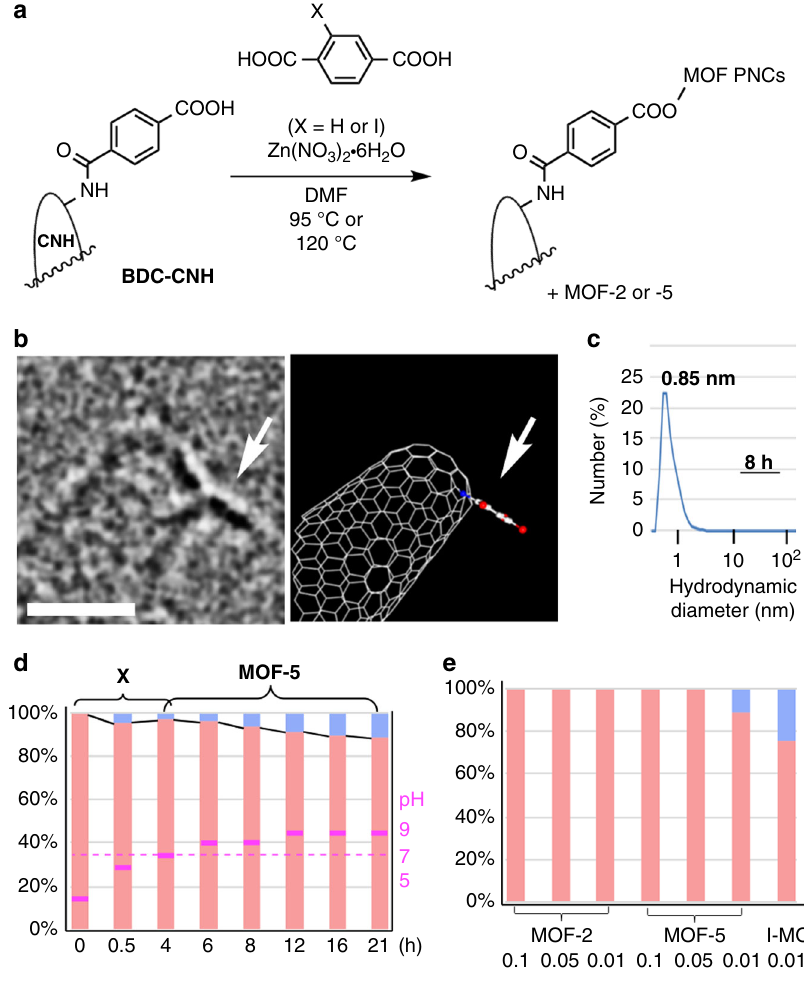
Fig. 2 BDC-CNH fi shhook for capturing PNCs of MOF-2 and MOF-5. a Procedure to capture PNCs of MOF-2 and MOF-5 on a ‘ fi shhook ’ of BDC-CNH. b TEM image (left) and molecular model (right) of a BDC moiety (indicated by an arrow) bound to the tip of the CNH. The scale bar is 1 nm. See Supplementary Fig. 7 for details. c DLS analysis (particle number average) of the fi ltrate of a reaction mixture of MOF-5 after 8 h. d The ratio between LO (pink) and HO (blue) clusters in the formation of X and MOF-5 at 120 °C. The data in purple indicate the pH of reaction mixture after dilution with water. The total number of the PNCs examined in the eight experiments shown are the following from the left to the right: 47, 27, 132, 133, 67, 58, 69 and 36. See in Supplementary Table 2 for the original data. e The LO/HO ratio at various Zn 2 + concentrations, as captured on BDC-CNH from the reaction of a mixture of H 2 BDC (or H 2 IBDC), Zn(NO 3 ) 2 (cid:129) 6H 2 O (2 equiv), and BDC-CNH heated for 21 h at 95 °C (MOF-2 formation) and 120 °C (MOF-5 and I-MOF-5). The total number of the PNCs examined in the seven experiments shown are the following from the left to the right: 45, 48, 56, 73, 33, 36 and 54. See in Supplementary Table 3 for the original